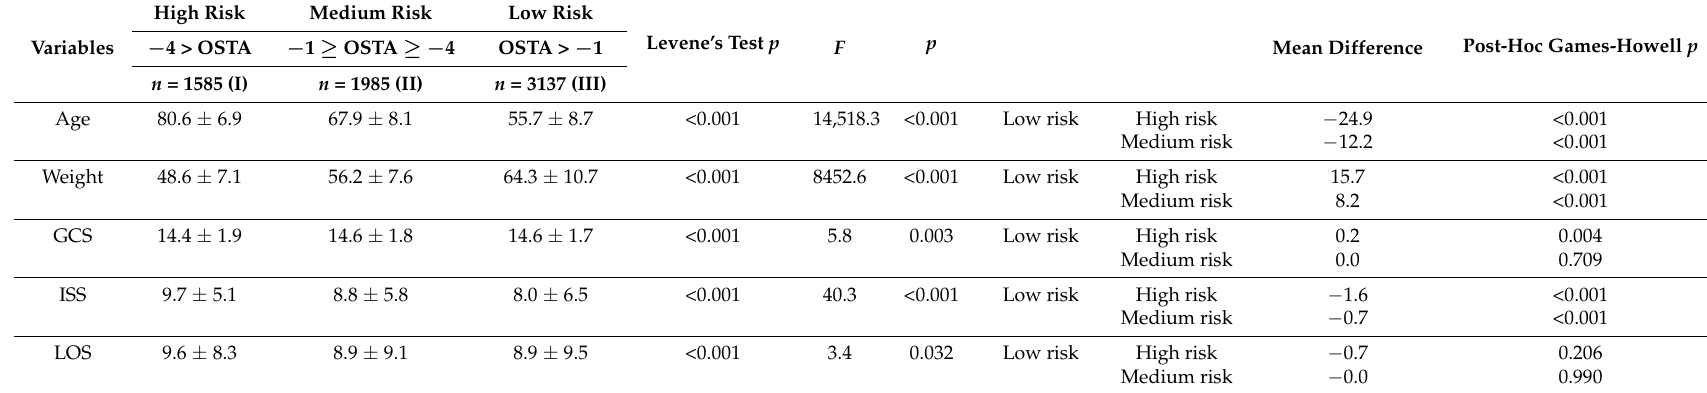
Table 1. Demographics and injury characteristics of continuous variables in high-risk (OSTA < − 4), medium-risk ( − 1 ≥ OSTA ≥ − 4), and low-risk (OSTA > − 1)